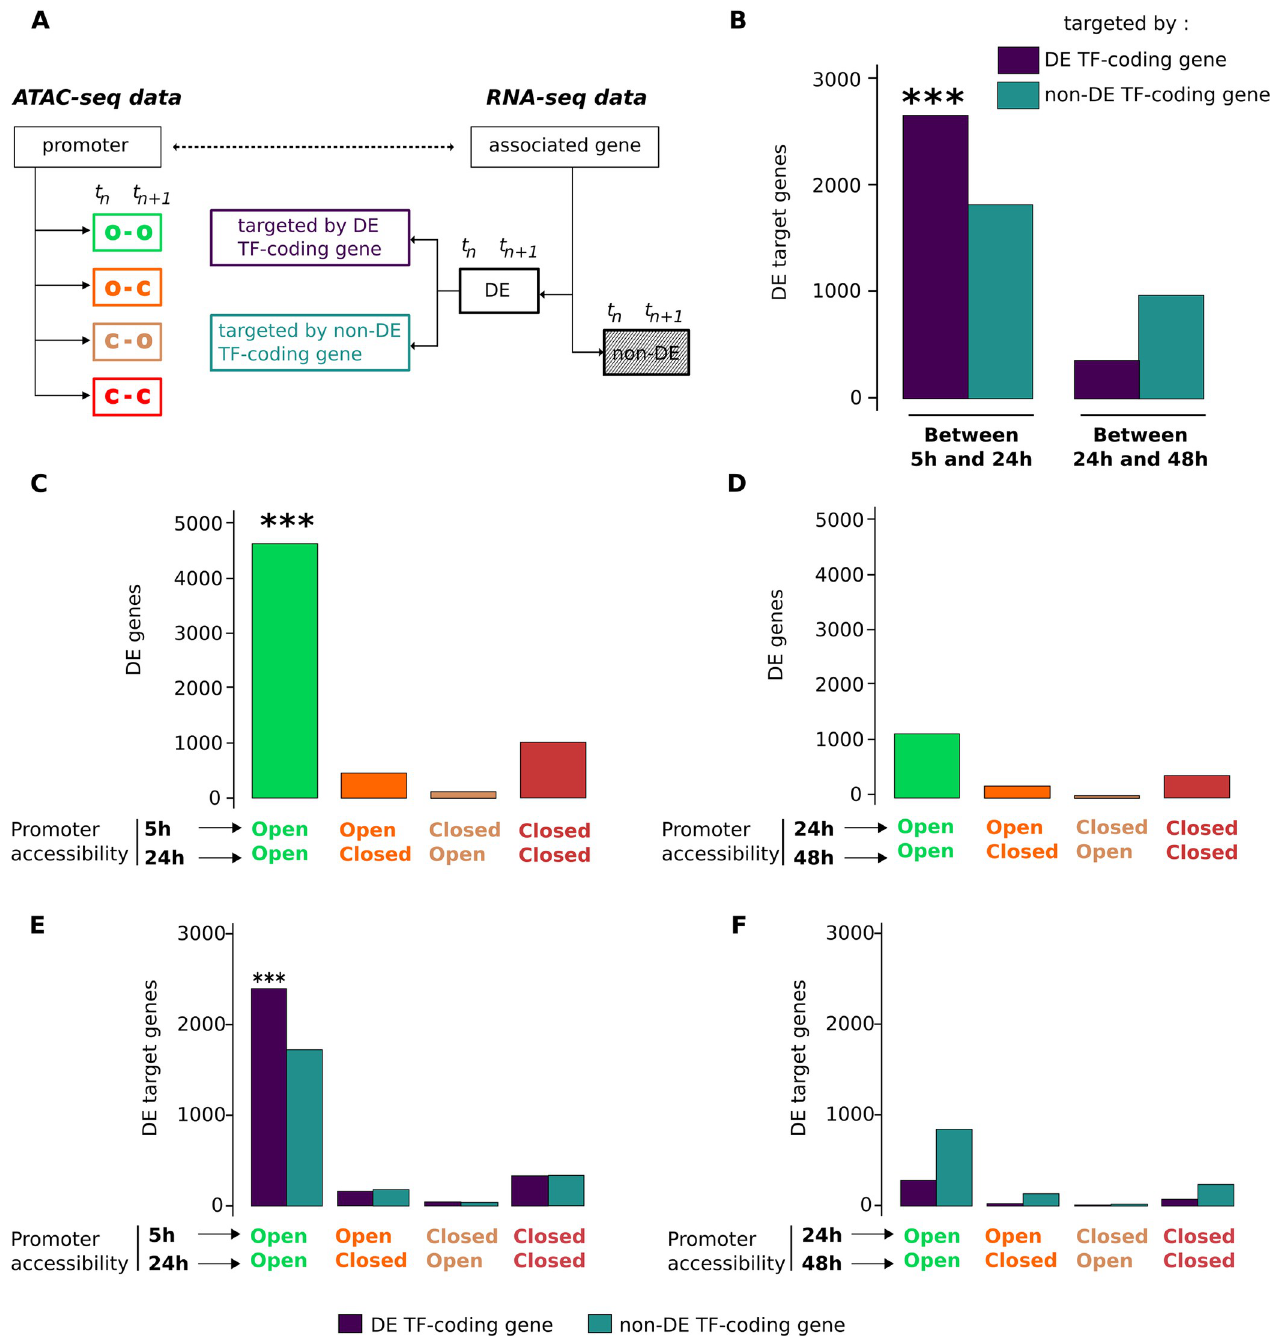
Fig 6. Integration of the ATAC-seq and scRNA-seq data. ( A ) Schematic representation of the classification of the gene promoters on the basis of their accessibility over an interval between 2 time points and genes depending how their transcription changes during the same time interval. The comparison of ATAC-seq and RNA-seq data was done using this classification. ( B ) Enrichment analysis of the DE target genes depending on if they were targeted by DE TF- coding-genes or non-DE TF-coding genes. Left panel: between 5 h and 24 h; right panel: between 24 h and 48 h. The color code identifies the genes targeted by DE TFs or non-DE TFs. As indicated by the asterisks, the genes targeted by DE TFs were overrepresented among the DE genes as determined by two-sided Fisher exact test ( p = 1.4 × 10 − 6 ). ( C , D ) The total number of DE target genes as a function of the evolution of the promoter accessibility between 5 h and 24 h ( C ) and 24 h and 48 h ( D ). Note that DE genes are significantly associated to the open-open promoter configuration between 5 h and 24 h (indicated by the asterisks; two-sided Fisher exact test: p < 10 − 4 ). ( E , F ) The total number of DE target genes as a function of the evolution of the promoter accessibility and as the function of if they are targeted by DE TFs (blue) or non-DE TFs (green) between 5 h and 24 h ( E ) and 24 h and 48 h ( F ) (each category represented on C ) and ( D ) is divided into two. Note that only the DE genes with open-open promoter between 5 h and 24 h and regulated by DE TFs are significantly